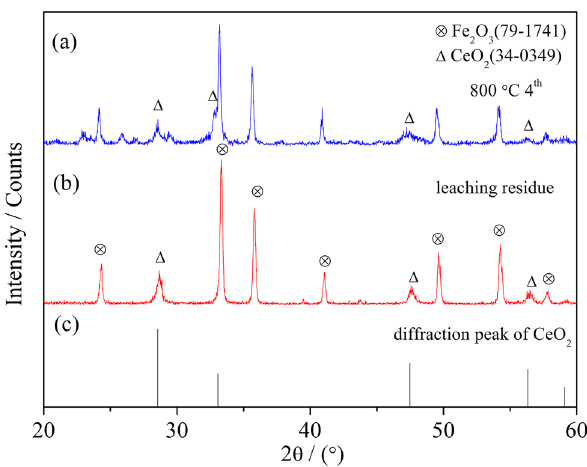
Figure 3: XRD patterns of completely oxidized Ce – Fe – B magnet scrap powder and the residue after leaching with hydrochloric acid. ( a ) XRD pattern of completely oxidized Ce – Fe – B magnet scrap powder; ( b ) XRD pattern of the residue; ( c ) standard XRD pattern of CeO 2